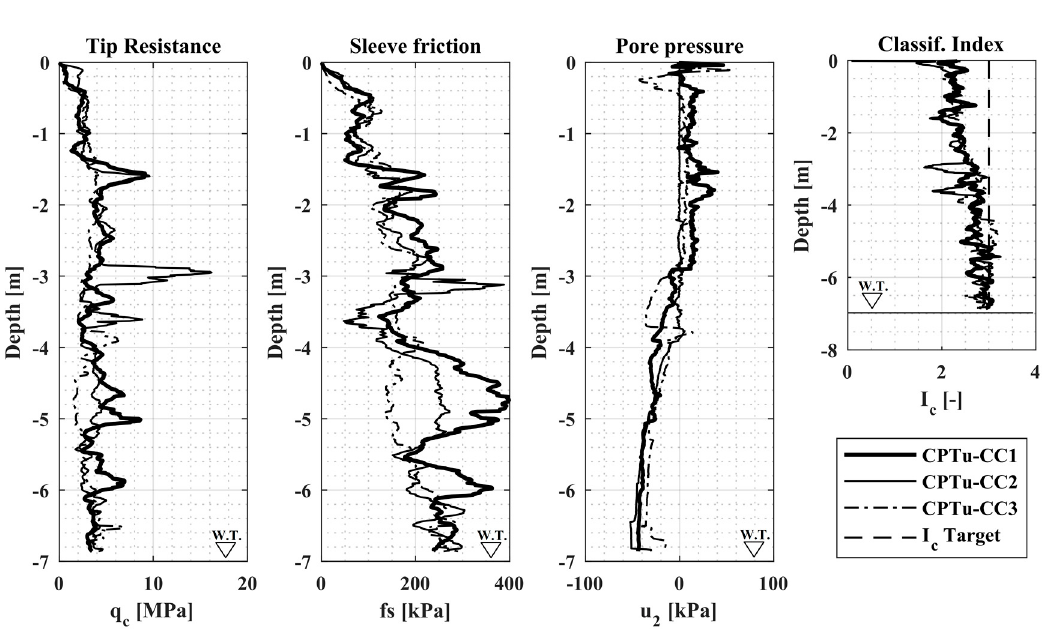
Figure 6. CPTu test results at CC site.